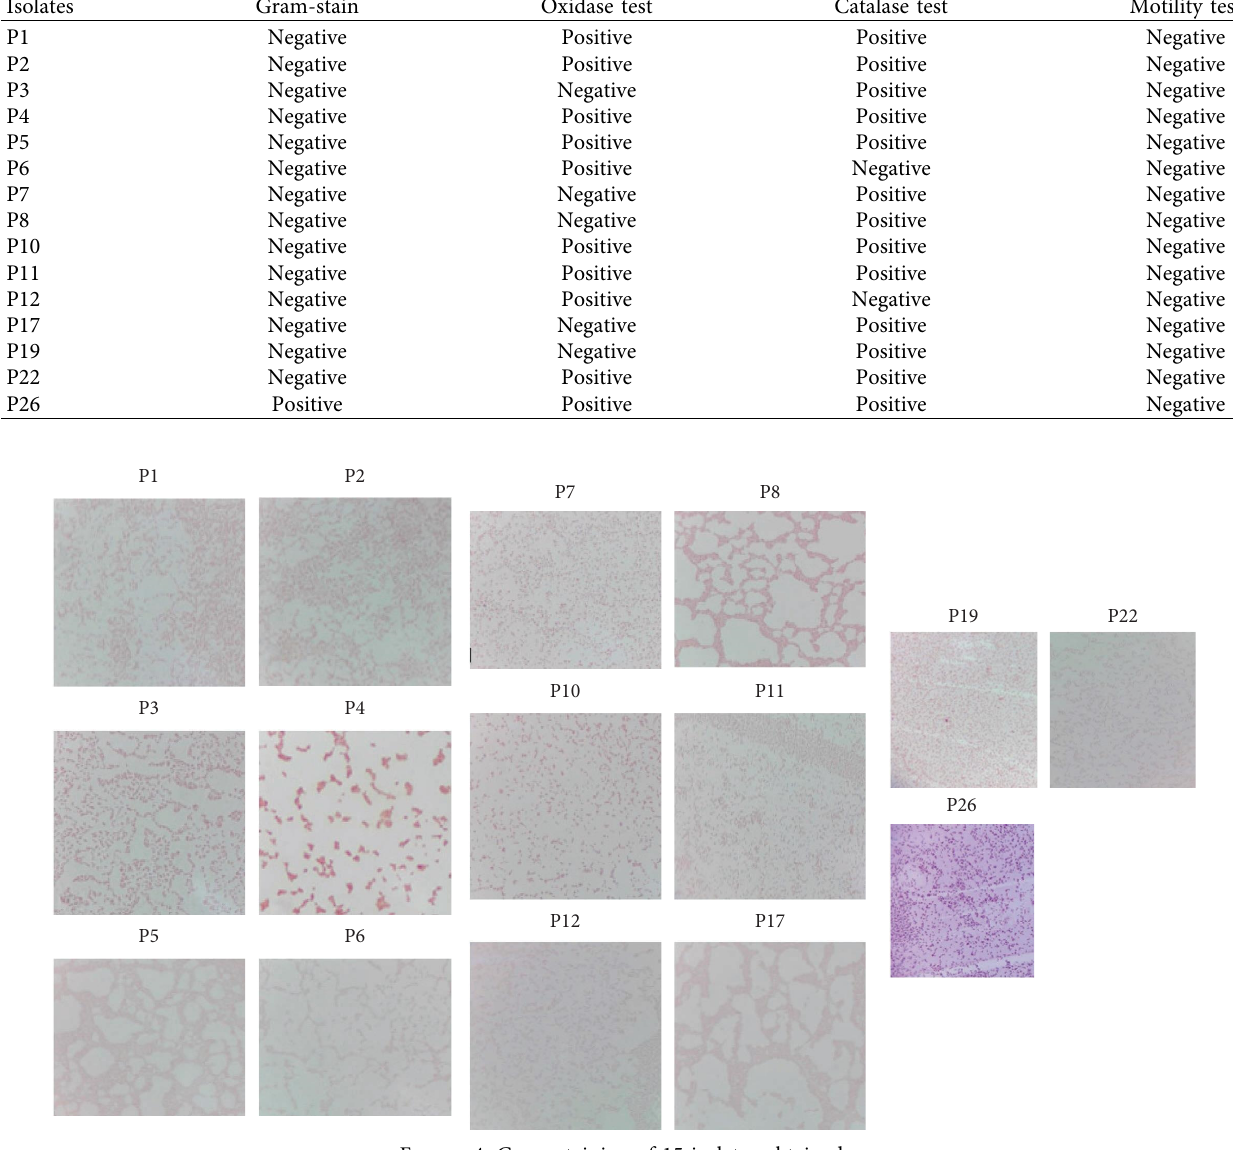
Figure 4: Gram-staining of 15 isolates